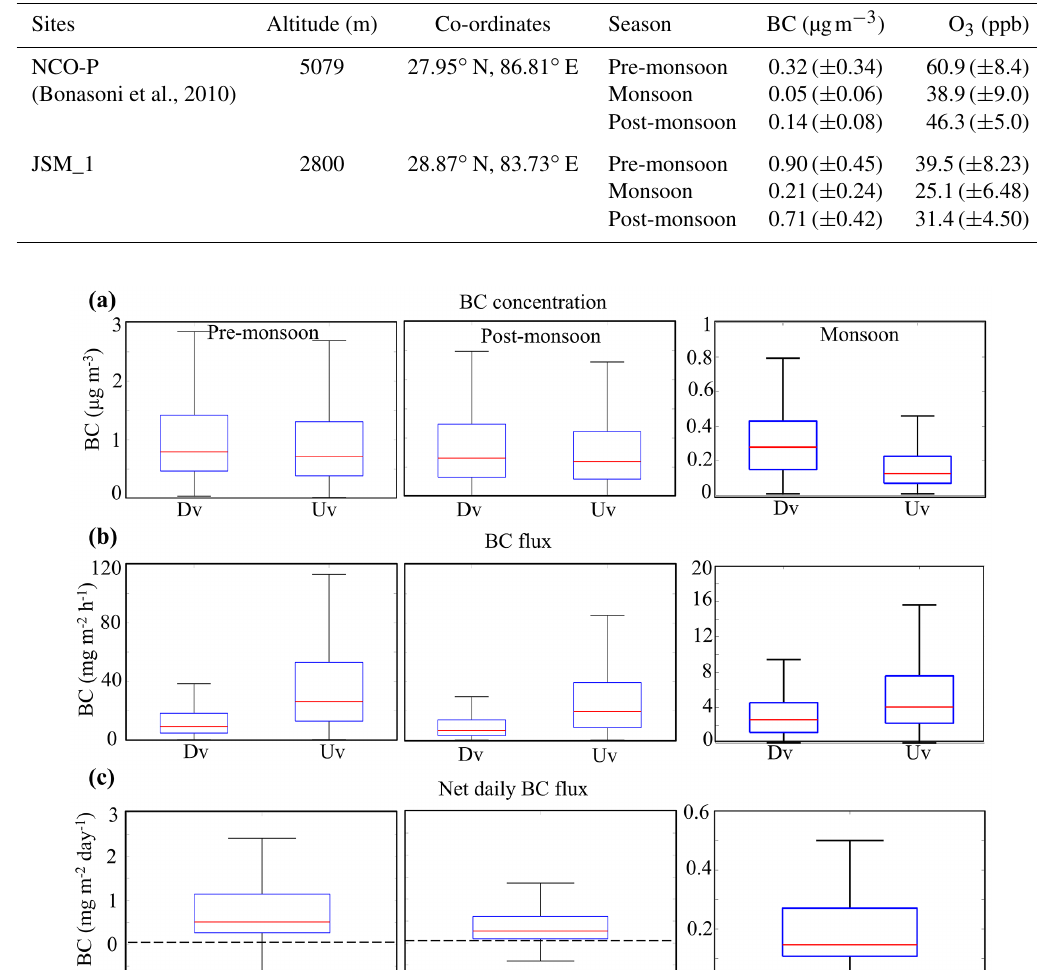
Table 1. Comparison of BC and O 3 concentrations (mean ± SD) between high-elevation Himalayan site NCO-P and JSM_1.